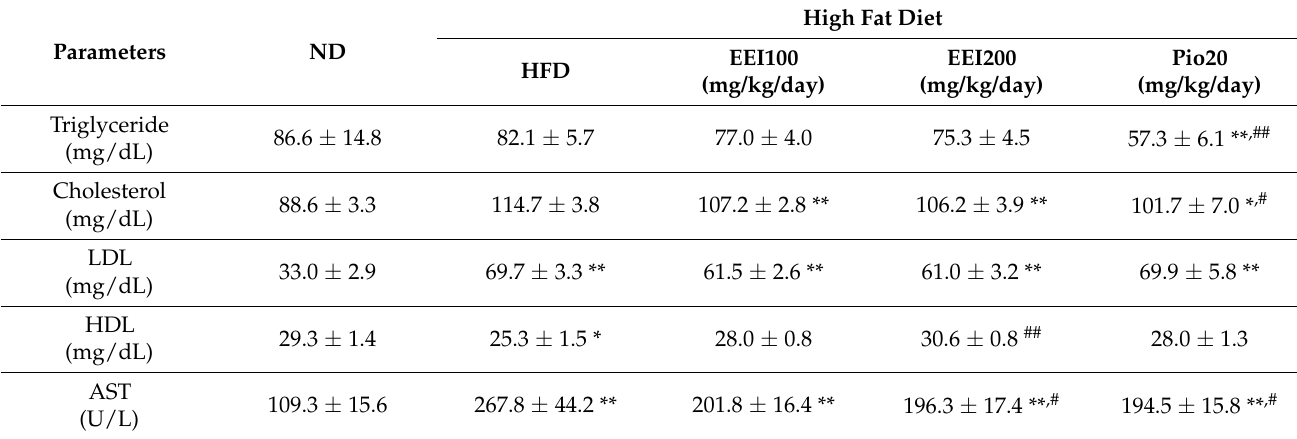
Table 3. The effect of 2-week feeding EEI on biochemical